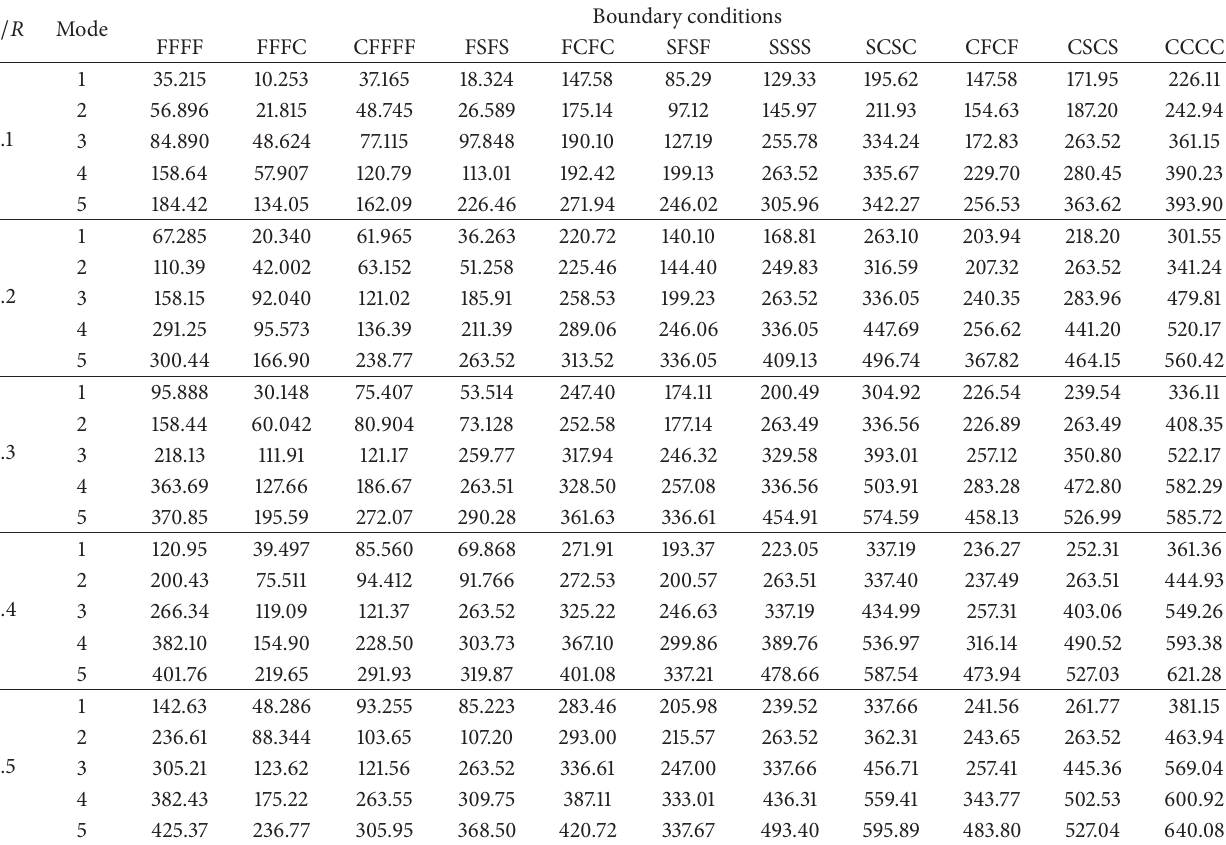
Table 9: The first five frequencies (Hz) of an open orthotropic cylindrical shell with various boundary conditions and thickness-radius ratios ( 𝑅 = 1 m, 𝐿/𝑅 = 2 , and 𝜃 0 = 𝜋/2